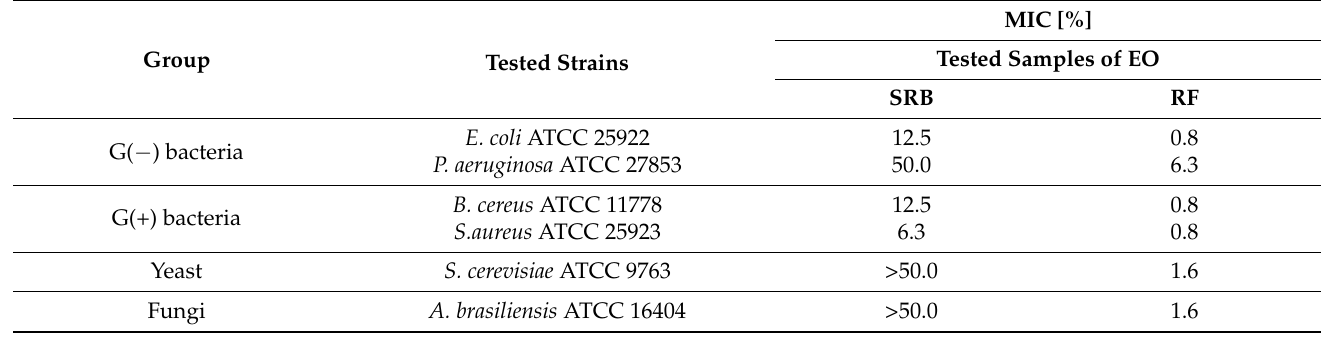
Table 4. Minimal inhibitory concentration (MIC) of rosemary EO from Serbia (SRB) and Russia (RF) assayed by the microdilution method.